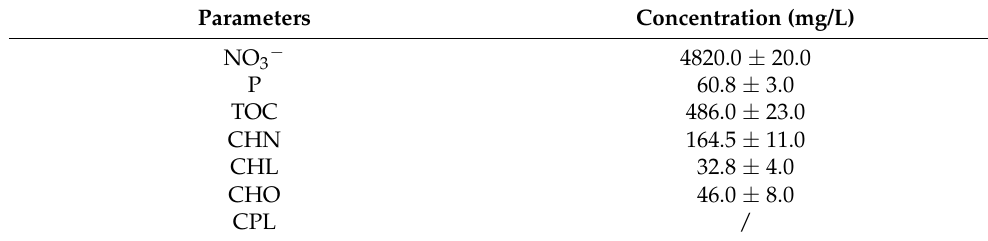
Table 1. Physicochemical characteristics of mixed caprolactam